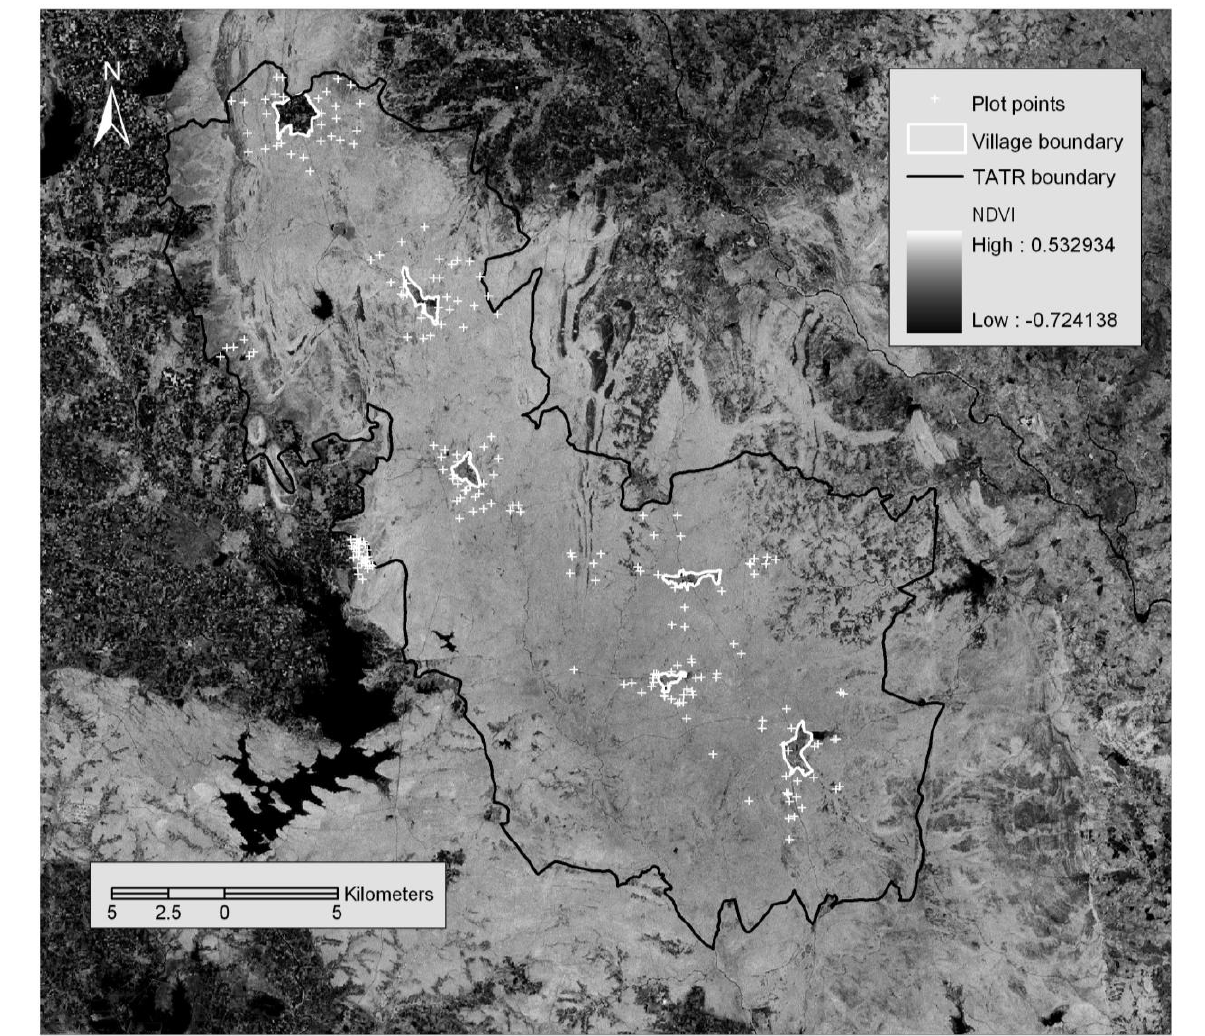
Figure 1. Study area map showing the location of the 211 field plots overlaid on a Normalized Difference Vegetation Index derived from a Landsat ETM+ image of 29th October